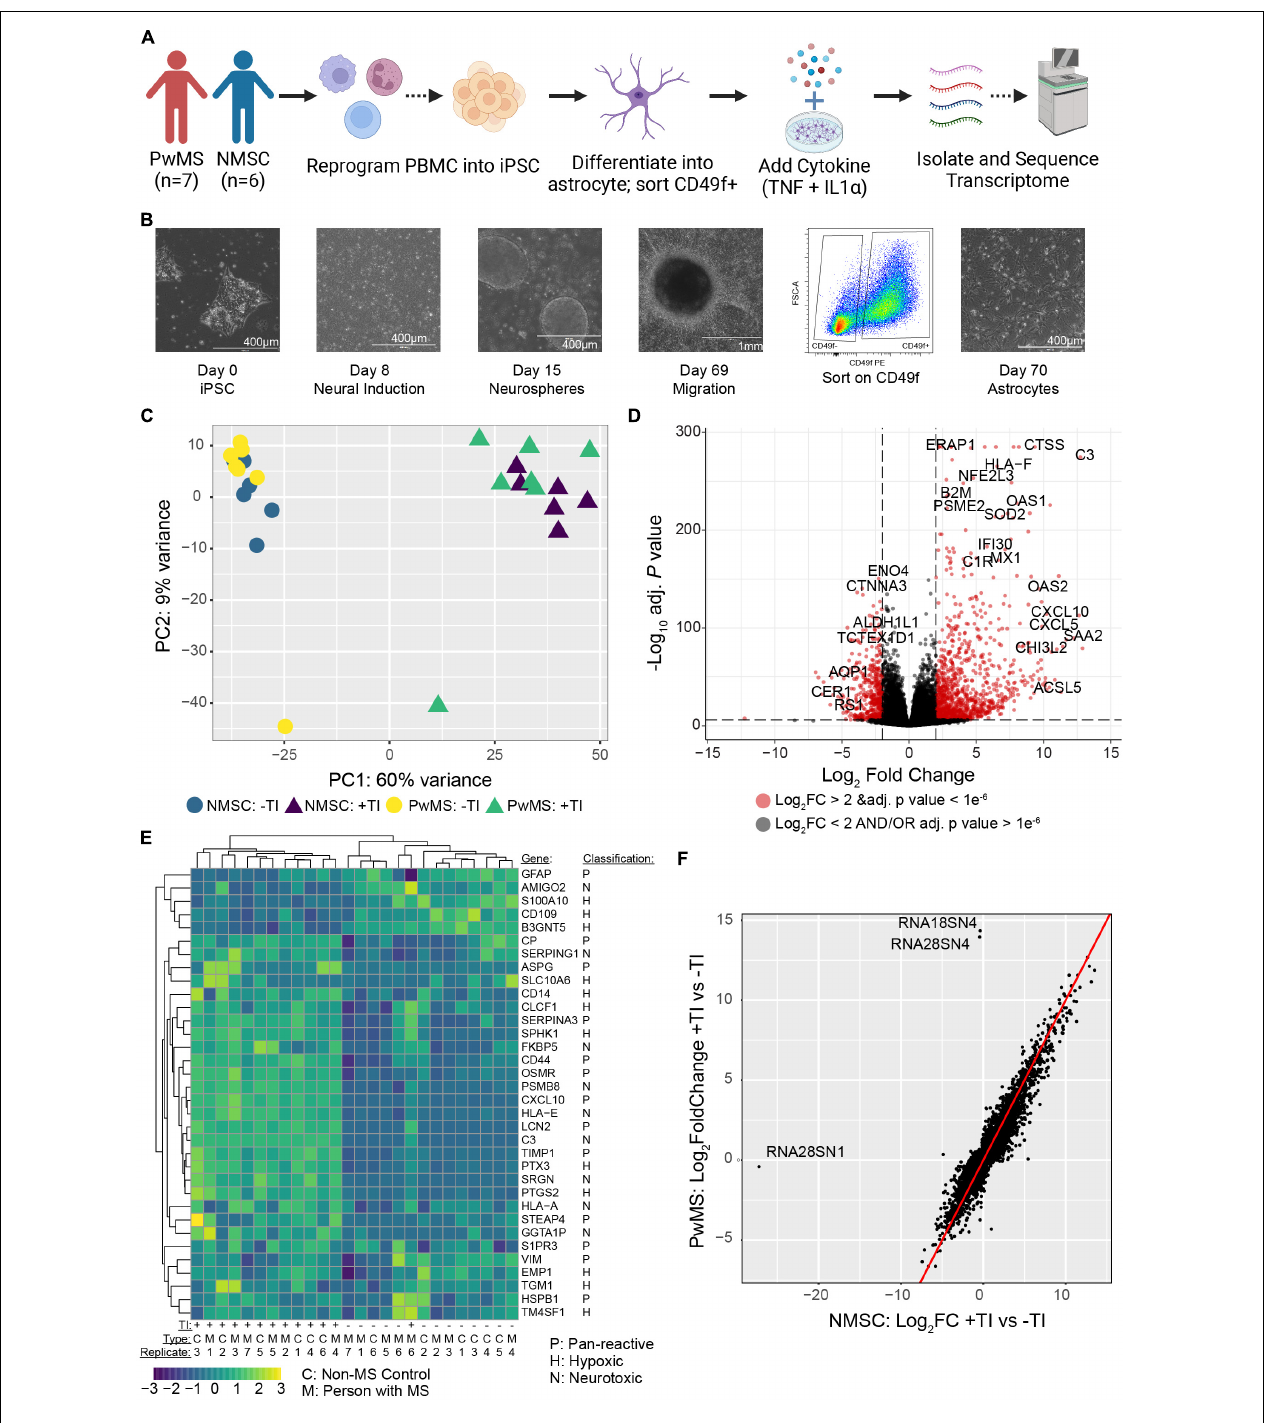
FIGURE 1 | Human induced pluripotent stem cell derived astrocytes from PwMS and NMSC respond similarly to TNF + IL1 α stimulation. (A) Schematic depicting experimental design. (B) Representative images showing stages of astrocyte differentiation from a PwMS. (C) Principle component analysis of top 500 most variable genes. (D) Volcano plot depicting results of differential expression testing comparing +TI treated astrocytes with –TI controls with a selection of the most significant genes labeled. (E) Heatmap showing clustering and relative expression of genes previously reported as characteristic of distinct sub-types of reactive astrocytes. Genes are classified as being previously reported as pan-reactive (P), associated with neurotoxic (N), or associated with hypoxic conditions (H). Samples are of Type C (NMSC) or M (PwMS). (F) X – Y scatterplot showing fold change of genes when comparing +TI to –TI conditions. Fold change of NMSC are on X -axis and of PwMS are on Y -axis. Red line has intercept of 0 and slope of 1. Most discrepant genes are labeled.